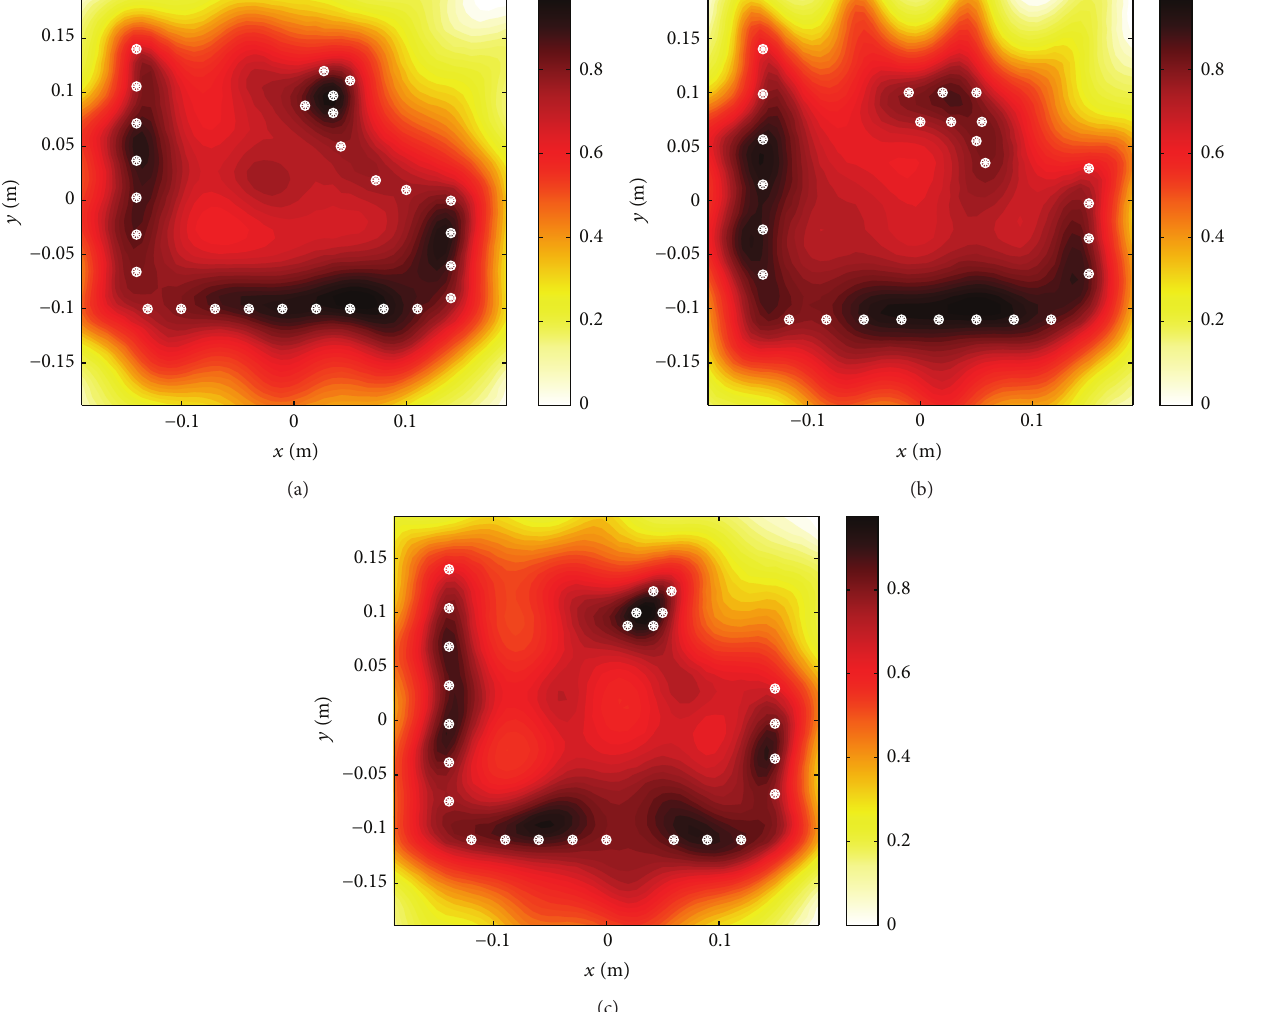
Figure 6: Example 2: LSM reconstructions by using measurement configuration A and corresponding pivot points. (a) Circular scanner, (b) square scanner, and (c) triangular